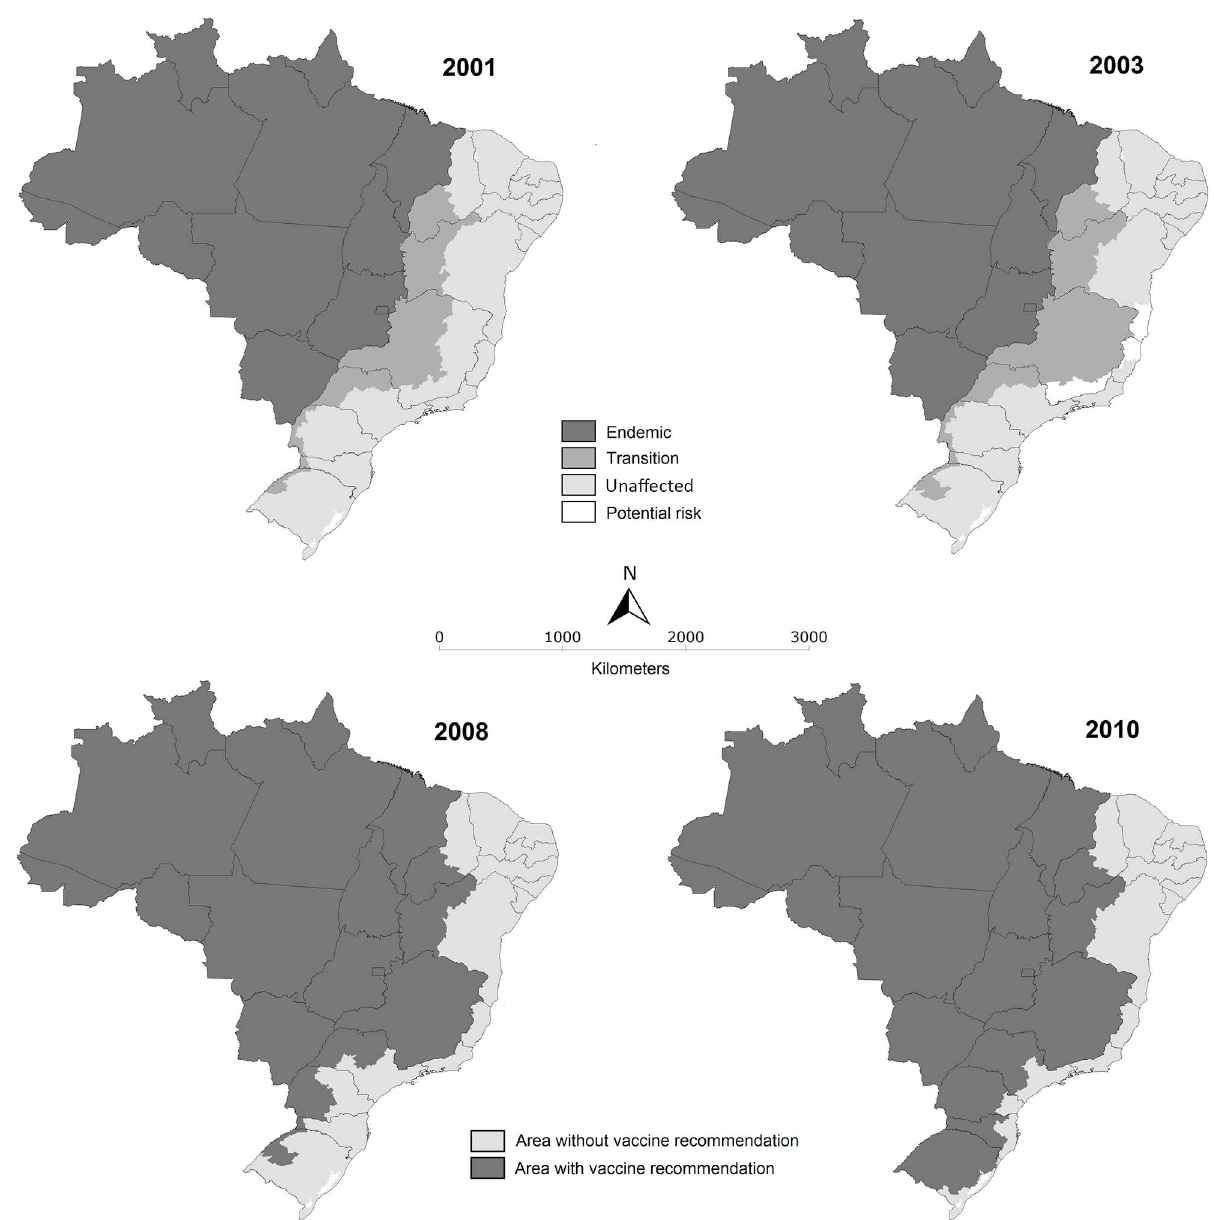
Figure 3. Evolution of geographic risk classification for yellow fever vaccination recommendations in Brazil, 2001–2010.